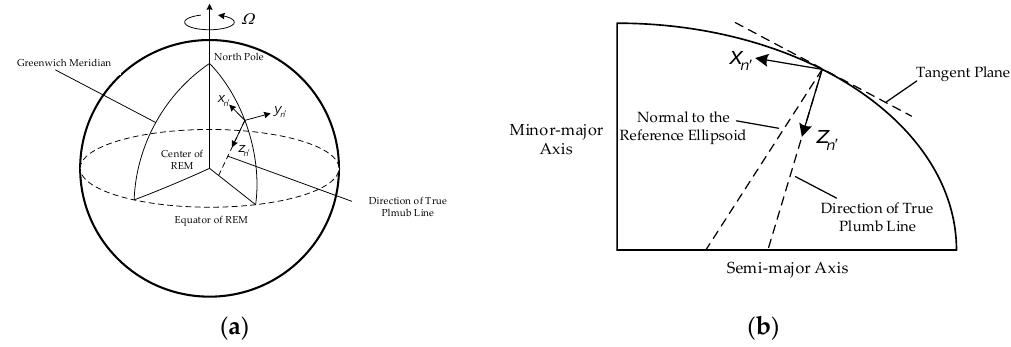
Figure 2. The definition of the navigation coordinate frame with true plumb line. ( a ) is the definition of navigation coordinate frame with true plumb line, ( b ) is the side view of ( a ).